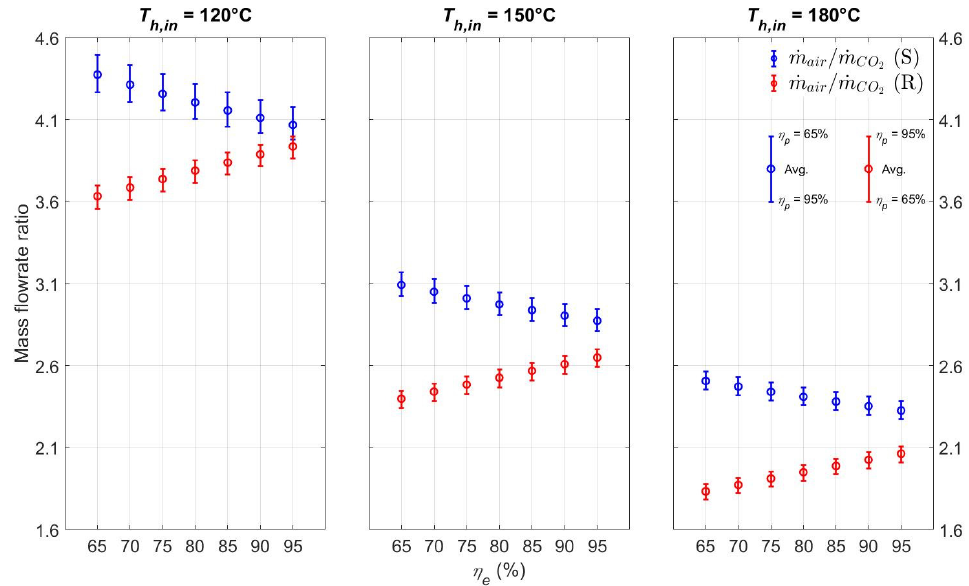
Figure 15. 𝑚(cid:4662) (cid:3028)(cid:3036)(cid:3045) / 𝑚(cid:4662) (cid:3004)(cid:3016)(cid:2870) at the design point under different circumstances of 𝜂 (cid:3043) , 𝜂 (cid:3032) , and 𝑇 (cid:3035),(cid:3036)(cid:3041) (S) = Simple cycle; (R) = Recuperative